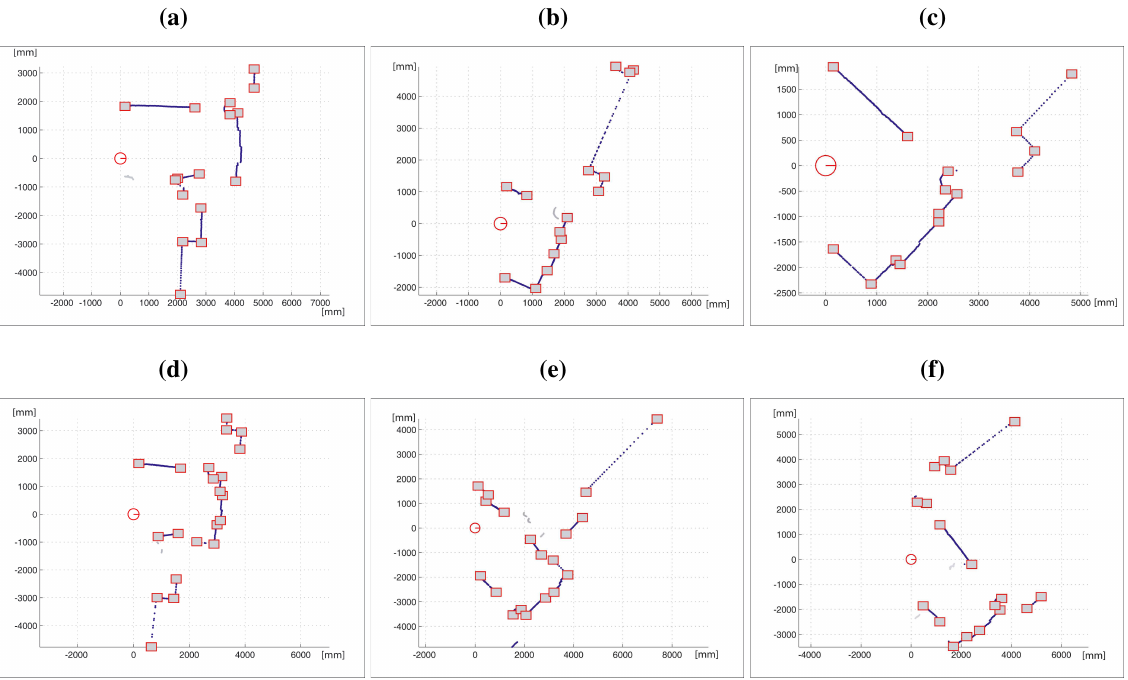
Figure 13. (a)–(f) Laser scan